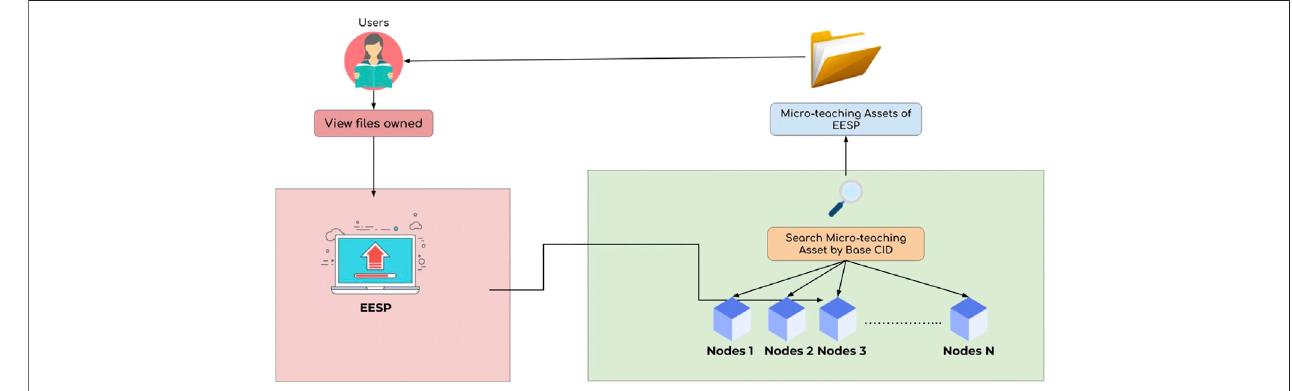
FIGURE 6 | EESP framework part 2.